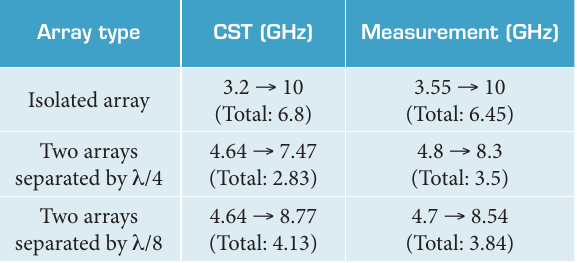
table 1. Operational frequency and bandwidth of the fss